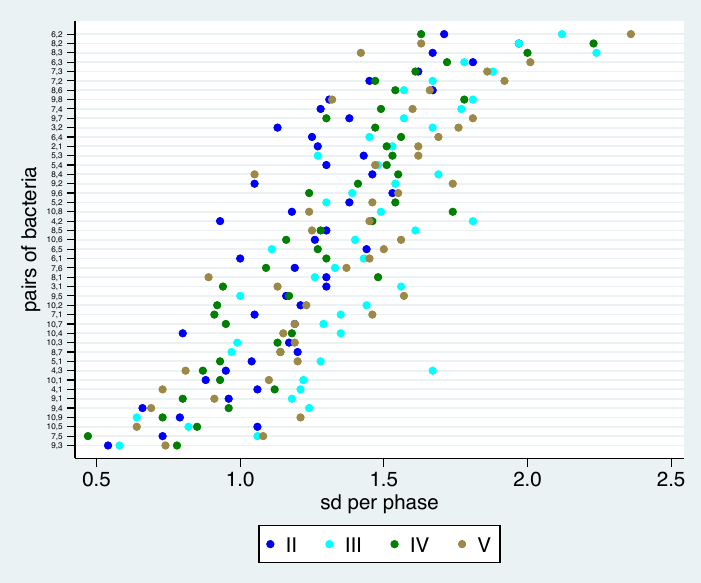
Figure 8. Standard deviation (sd) for phase-based log ratios for changes for all pairs of bacteria and phases estimated empirical and sorted by mean of sd over the